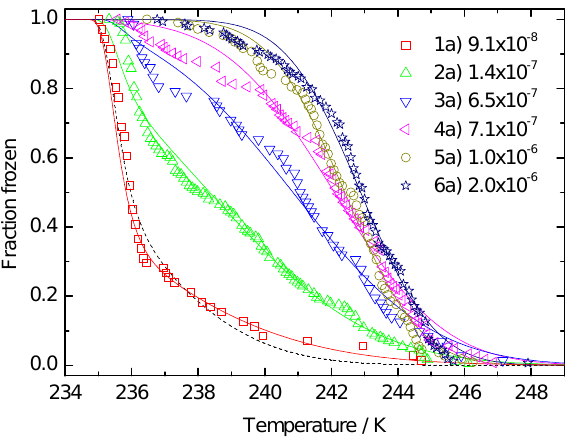
Fig. 13. Model fits to a range of experimental fraction frozen curves using the externally mixed multiple component stochastic model. The experimental data was all for 5Kmin − 1 cooling rates for a range of NX illite surface areas (given in the key with units cm 2 ) . a was set to 15 and a least squared fitting routine was used to obtain the best fit by varying µ b and σ 2 . The corresponding distributions, b P b,i , of the parameter b are shown in Fig. 14. Two fits to run1a are shown (red). The dotted line is a fit to the whole data set, while the red line is a fit to only the data points above 237 K. The dotted line provides a better fit to the whole data set, however, the solid red line clearly provides a better fit to the portion of the data dominated by heterogeneous freezing and it is this distribution plotted in Fig. 14.